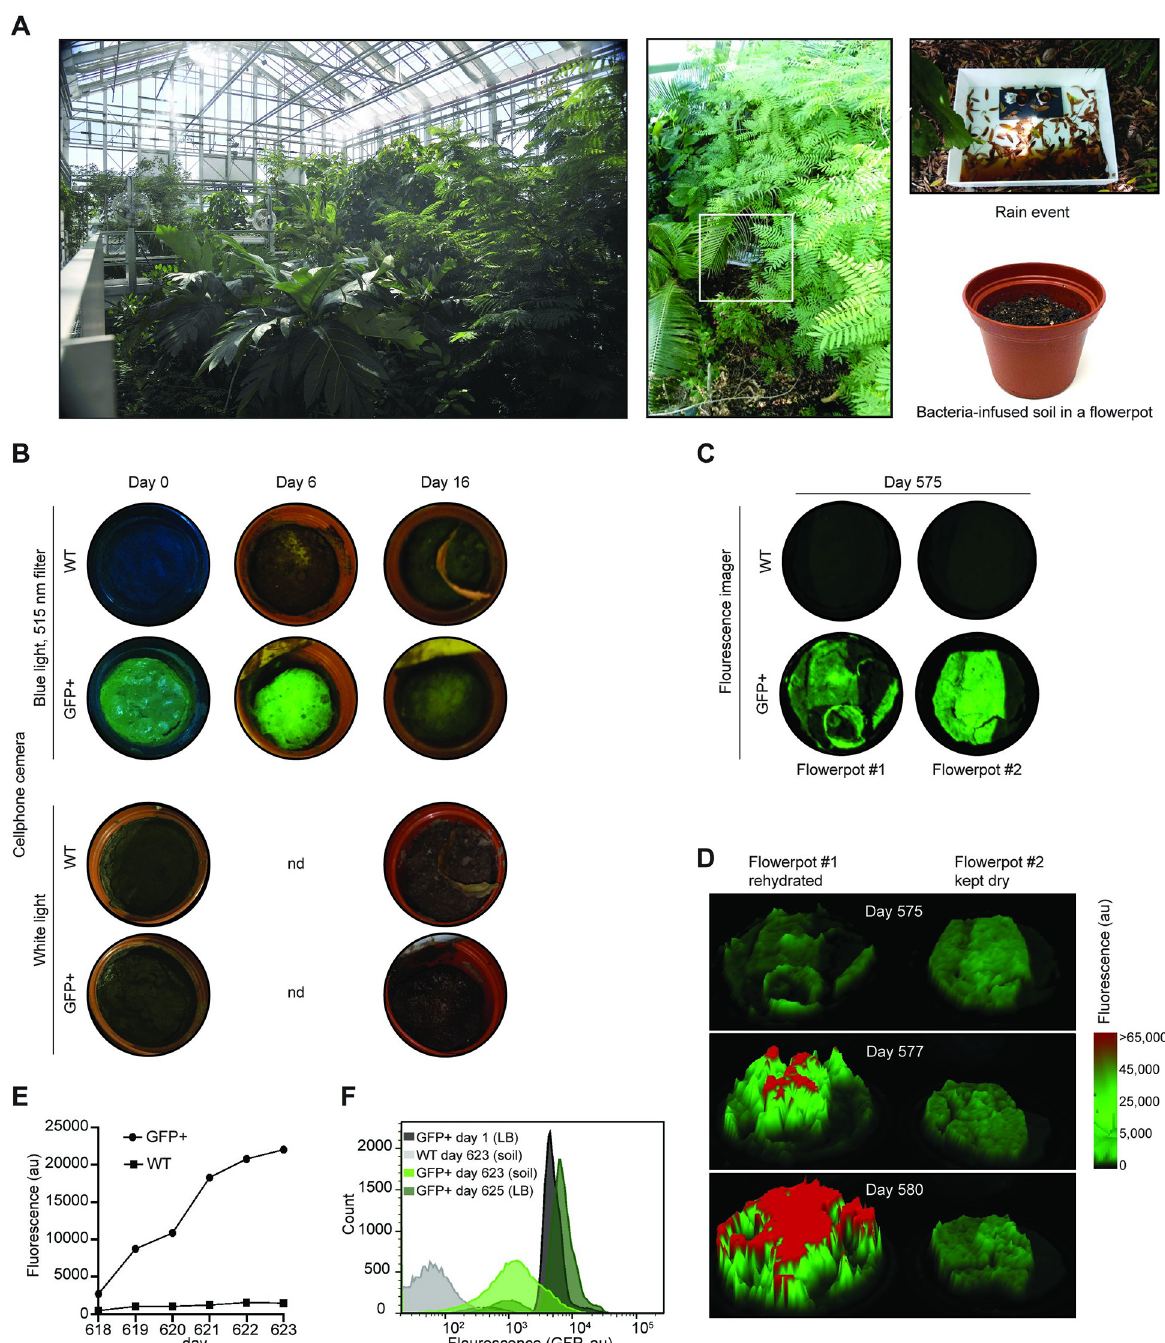
Fig 4. Bacterial prototyping in replicated environments. (a) Jungle room photos, showing the location of the B . frigoritolerans A3E1 infused soil samples in flowerpots on a rain event on day six. (b) Simulated environment survival experiment results. Cell-phone pictures of Wildtype and GFP + B . frigoritolerans A3E1 containing pots under Blue LED flashlight illumination (450 nm) and 505 nm filter (top) and white light (bottom) at three time-points during the experiment. (c) Fluorescent images of GFP+ and WT containing soil flowerpots on day 575 of long-term storage (d) Representative comparison between rehydrated (left) and dry (right) GFP+ containing pots and during the rehydration process. Mountain plots describe GFP fluorescence intensity. The red color represents over-exposure. The experiment has been replicated twice. (e) Quantification of the soil-surface mean fluorescent levels during the rehydration experiment. Day 618 timepoint represents the background fluorescence level before rehydration. The standard error of the mean was calculated and was too small to be observed on the graph. (f) Flow cytometry measurements of GFP+ and WT B . frigoritolerans A3E1 population fluorescence directly after separation from the soil on day 623 (bright green) and after overnight